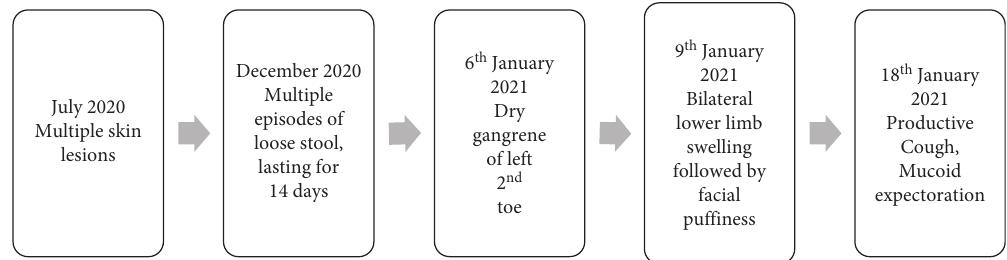
Figure 1: Timeline of symptoms onset.